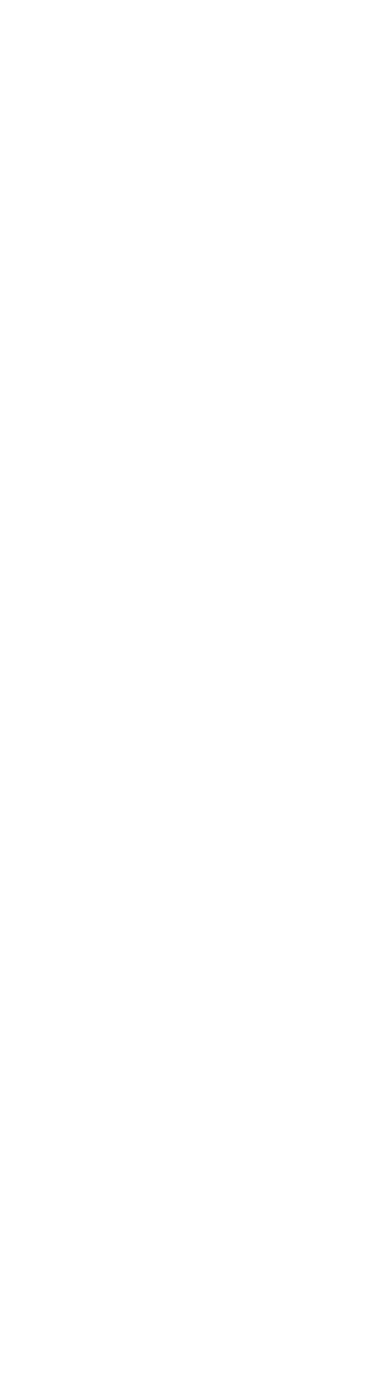
FIGURE 4 Accumulated rainfall threshold levels for partitioning weather